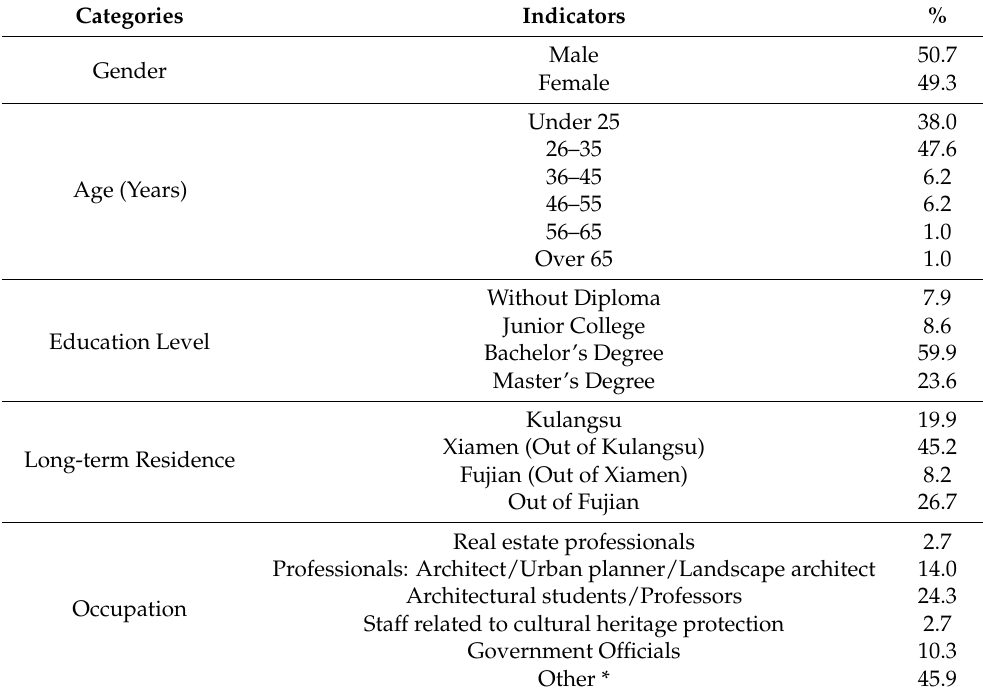
Figure 6. The geographical distribution of participants based on IP address analysis (made by author). Table 6. Comprehensive profile of the participants in the Kulangsu cultural heritage survey (made by author).